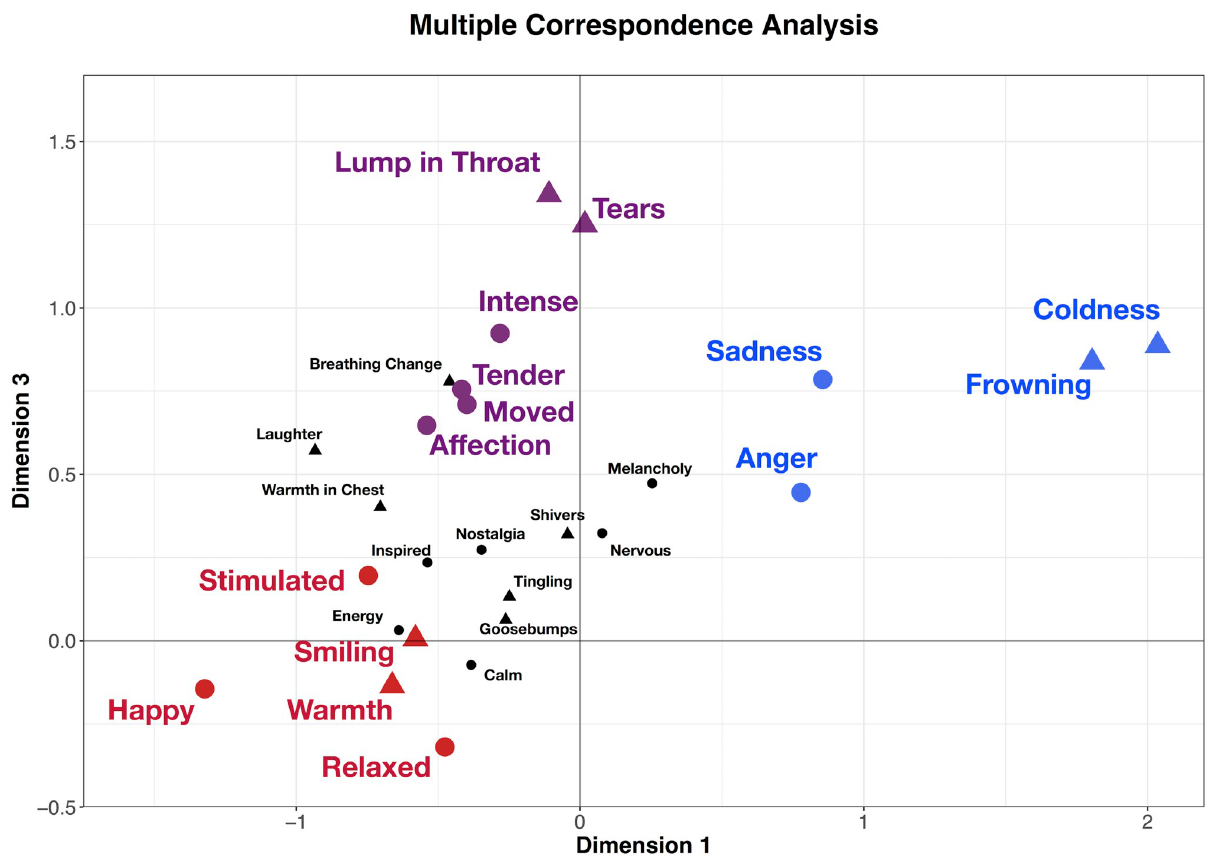
Fig 1. Visualization of the Multiple Correspondence Analysis. Shapes indicate physical (triangle) and emotional (circle) responses, and colours indicate chills categories developed through MCA and polyserial correlations (red = warm chills , blue = cold chills , purple = moving chills